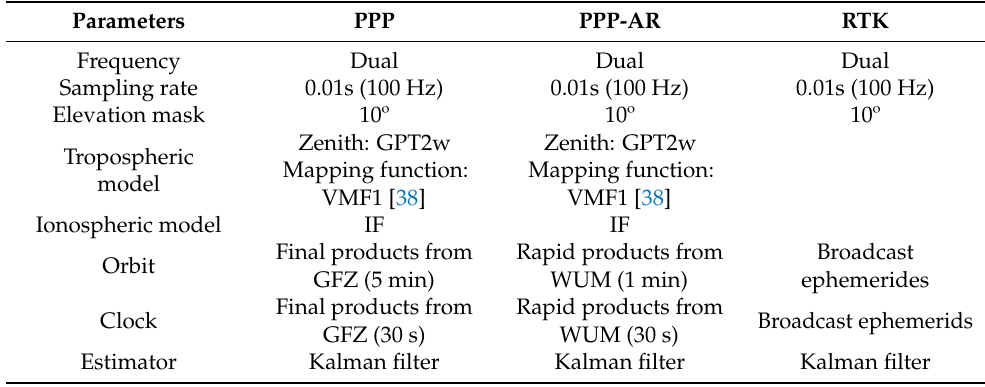
Table 1. Details of PPP, PPP-AR, and RTK data processing.